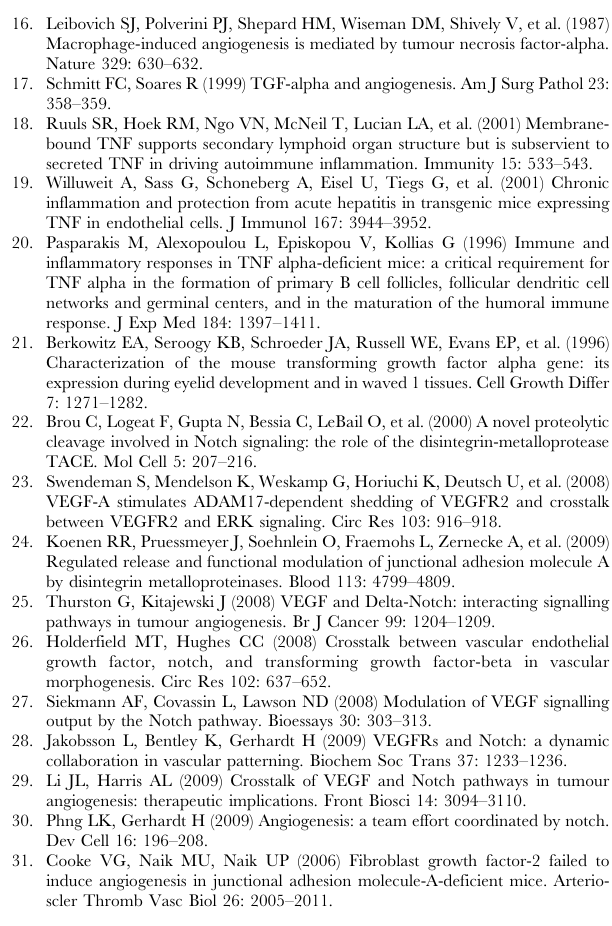
Figure S1 Genotyping and weight of progeny derived from Adam17 D Zn/ + intercrosses. A, The number of viable embryos of each genotype is listed and the number of additional dead fetuses is indicated in parentheses. B, The weights of the embryos of each genotype were measured at E14.5 and E17.5; no statistical differences were observed among the different genotypes. Values are represented as mean 6